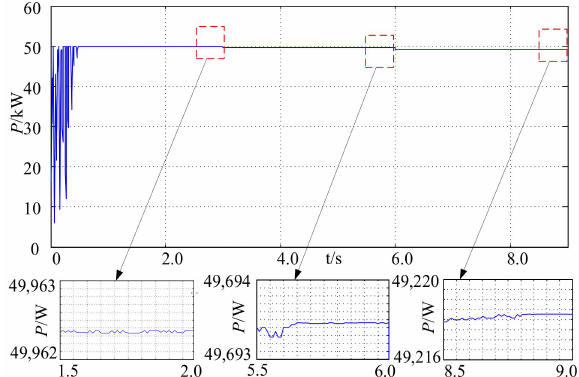
Figure 12. Power waveform of IFA under gradual change